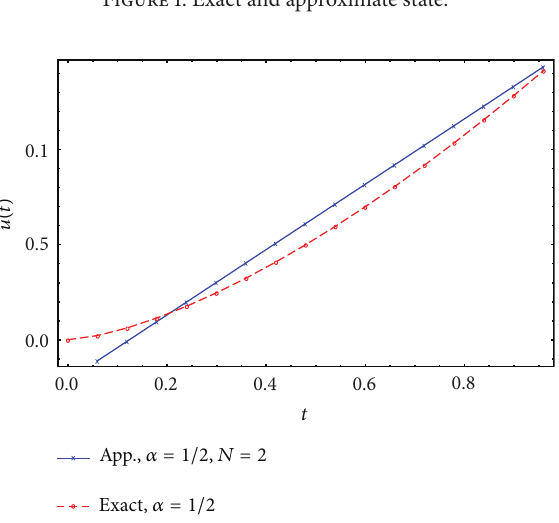
Figure 1: Exact and approximate state.